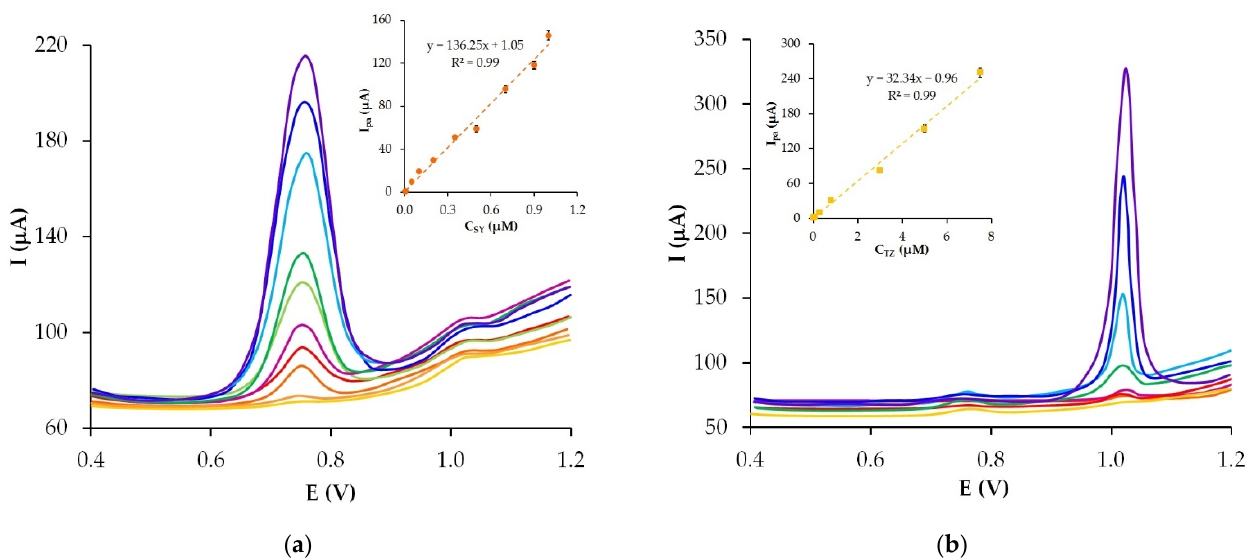
Figure 10. Differential pulse voltammograms of different SY concentrations (0.005, 0.01, 0.05, 0.1, 0.2, 0.35, 0.5, 0.7, 0.9, 1.0 μ M) in the presence of 0.5 μ M TZ ( a ) and different TZ concentrations (0.02, 0.04, 0.08, 0.3, 0.8, 3.0, 5.0, 7.5 μ M) in the presence of 0.2 μ M SY ( b ). Inserts: linear dependences of anodic peak current vs. dye concentration. Supporting electrolyte: phosphate buffer solution pH 5, accumulation time 180 s.